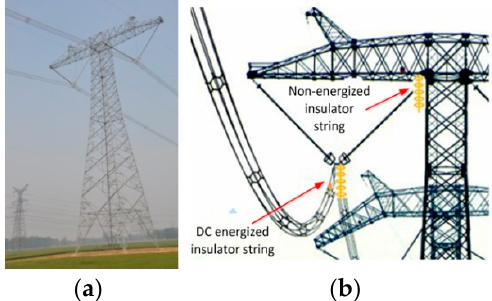
Figure 1. Field pollution test of transmission line operating insulators. ( a ) the ±800 kV transmission line view; ( b ) Diagram natural contamination insulator string sample arrangement.